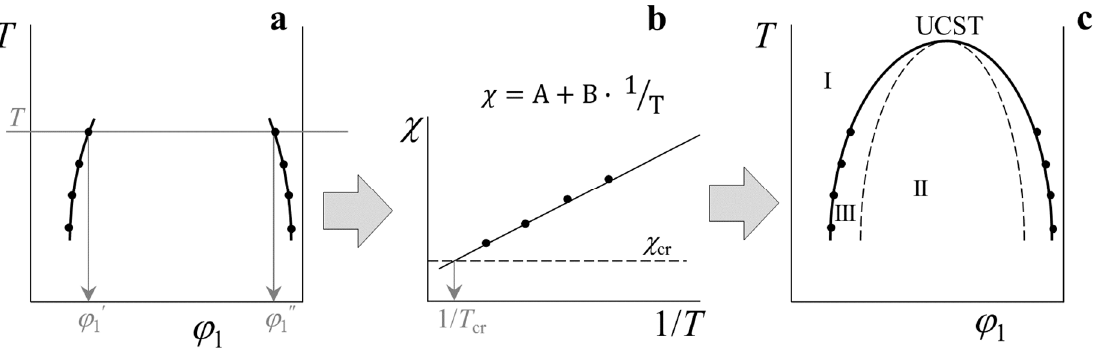
Figure 1. Method for simulation phase diagrams from fragments of binodal curves in the framework of the Flory–Huggins theory: ( a )—initial data on solubility, ( b )—temperature dependence of χ , ( c )— simulation of a generalized phase state diagram. Black dots—experimental data, solid thick lines— binodal curves, dashed line—spinodal curve. (See text for details).